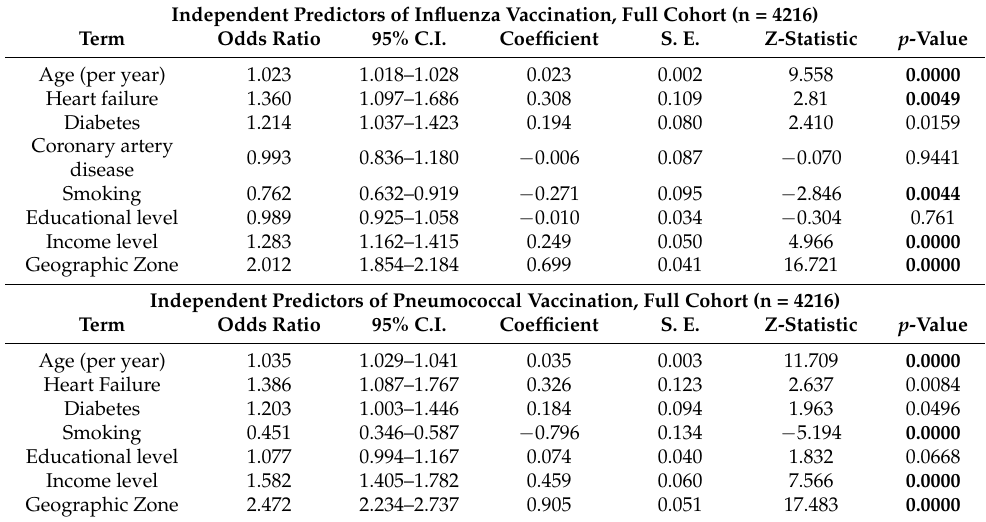
Table 3. Multivariate analysis, independent predictors of Influenza vaccination and Pneumococcal